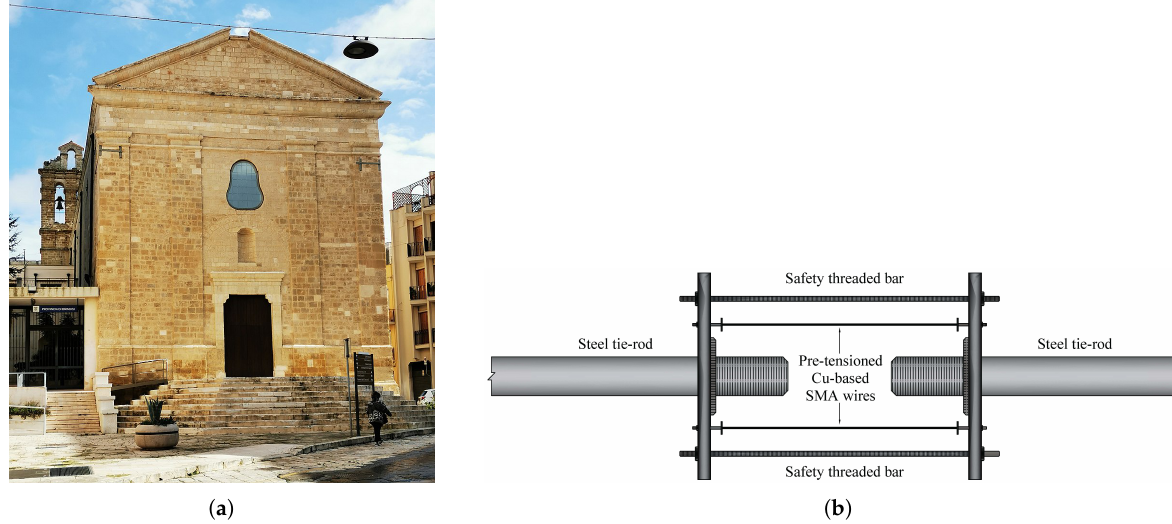
Figure 14. Retrofitting of the San Paolo Eremita church; ( a ) San Paolo Eremita church (photo by Saggittarius A.) ( b ) schematic of the proposed SMA-based system